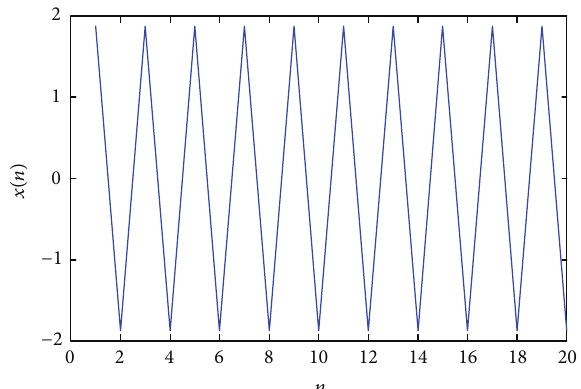
Figure 4: It shows the periodicity of the solution of (9) when 𝑙 = 4, 𝑘 = 3, 𝑥 3, and 𝑑 = 2